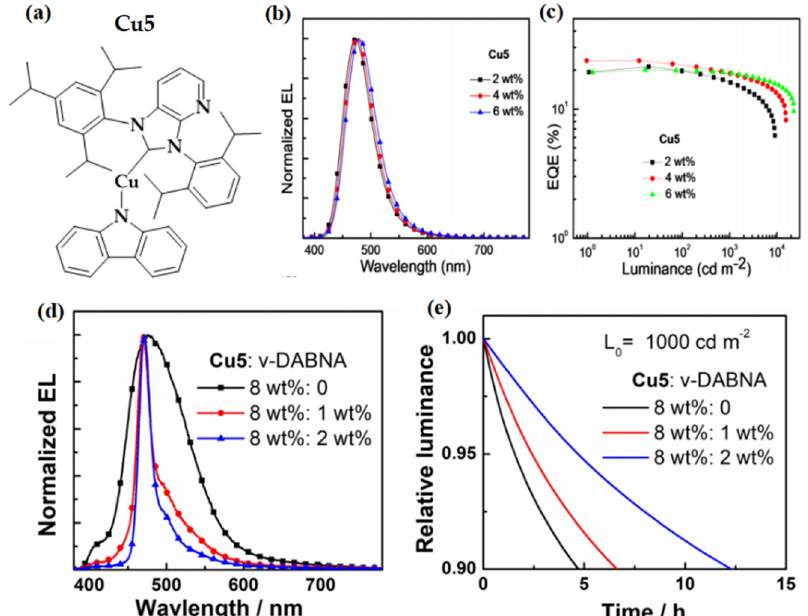
Figure 11. ( a ) Molecular structure of Cu5; ( b ) normalized EL spectra; ( c ) EQE–luminance of OLEDs based on Cu5 with various doping concentrations ranging from 2 to 6 wt%; ( d ) EL spectra; and ( e ) relative luminance versus operation time at an L 0 of 1000 cd m − 2 of the hyper-OLEDs with Cu5 and v-DABNA. Reproduced with permission from Rui Tang, Shuo Xu, Tsz-Lung Lam et al., “Highly Robust CuI-TADF Emitters for Vacuum-Deposited OLEDs with Luminance up to 222 200 cd m − 2 and Device Lifetimes (LT90) up to 1300 hours at an Initial Luminance of 1000 cd m − 2 ”; published by John Wiley and Sons , 2022 [62].